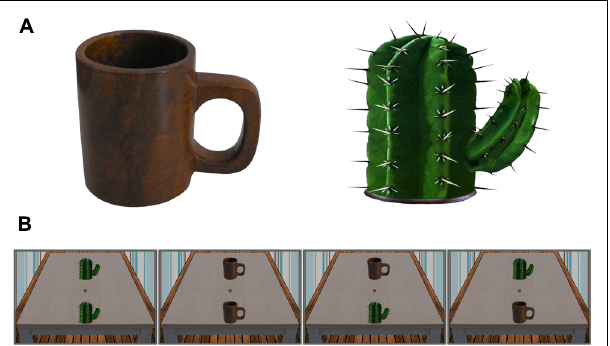
FIGURE 1 | Objects used in the present experiment. (A) Cup (left) and cactus (right), shown here without background. (B) Stimuli in the probe detection task.Two objects appeared on the table on screen, one of which changed its luminance 200 ms after stimulus onset.The two left displays represent the identical-objects conditions, the two right displays show the different-objects